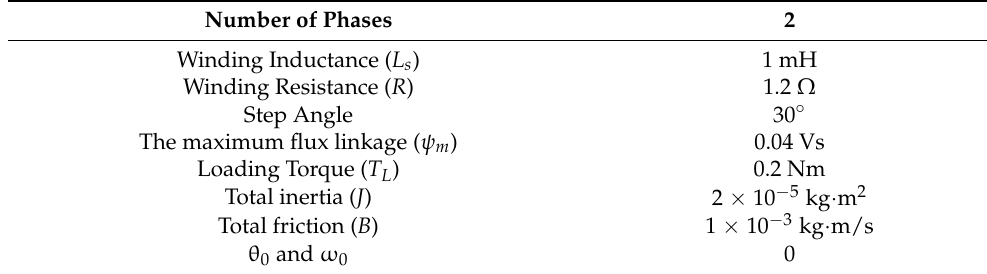
Table 2. Data of two-phase hybrid stepper